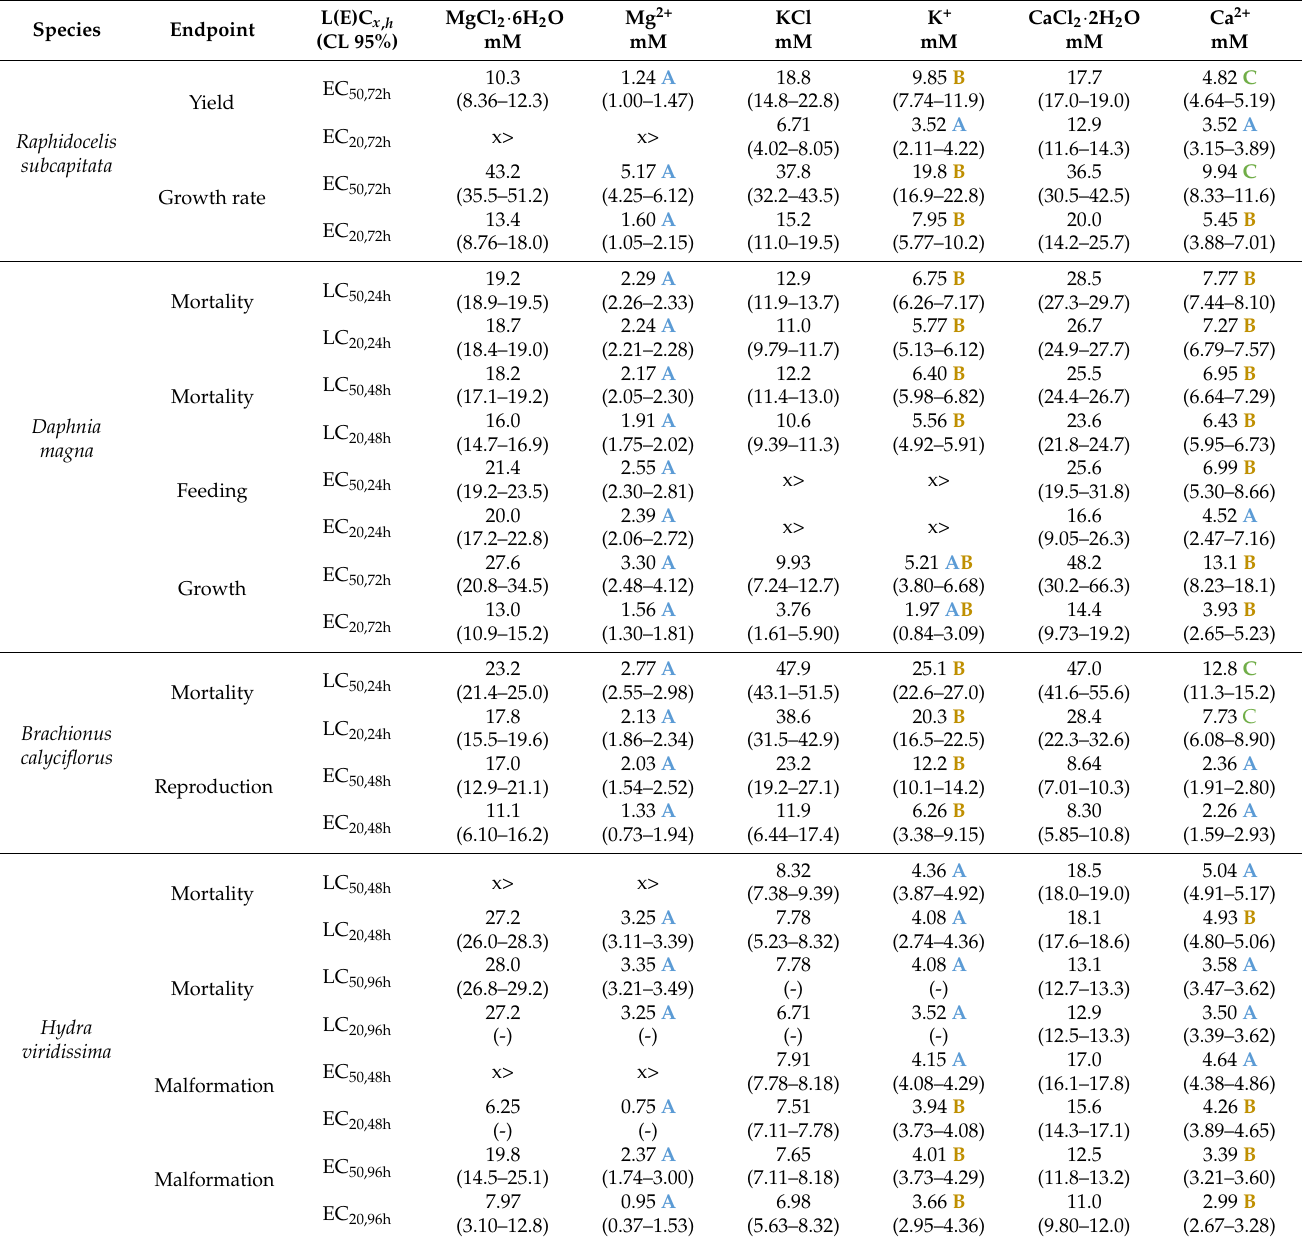
Table 1. Summary of the concentrations (expressed in molarity) causing 50% and 20% of effect after h hours of exposure [L(E)C x , h ] to increased concentrations of magnesium chloride (MgCl 2 ), potassium chloride (KCl), and calcium chloride (CaCl 2 ) salts and respective correspondence in relation to the respective cation concentration (Mg 2+ , K + , or Ca 2+ ). Confidence limits at 95% (CL 95%) are depicted inside